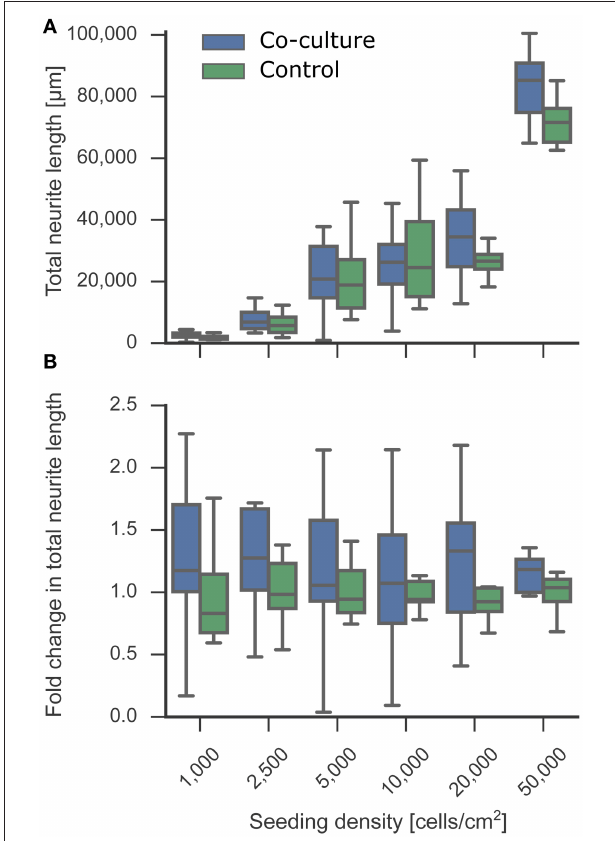
FIGURE 4 | Effect of co-culture on neurite length as an indicator for neuronal development. The neurite length of the experimental neuron cultures in co-culture and control condition was measured at 5 DIV. Tracing and quantification was done using the ImageJ Plugin NeuriteTracer. (A) Comparison of neurite lengths of the experimental neuron cultures between co-culture and control conditions. (B) The fold change of the resulting total neurite length indicated a trend toward an increased neurite length in the co-culture condition compared to the mono-culture control. In the plot, the box corresponds to the first and third quartiles with the median. The median is indicated with a horizontal line in the box, and the maximum and minimum are at the ends of the whiskers. Measurements 1.5 interquartile ranges below the first quartile or above the third quartile are classified as outliers and